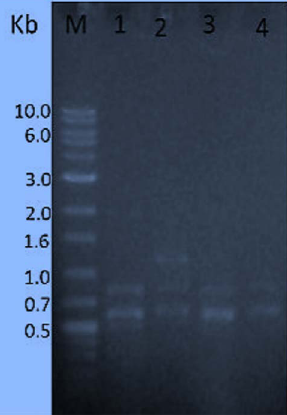
Fig. 4. DNA amplified banding profiles using primer (R3) based on RAPD for three Superior mutants (Lanes 2 to 4) and S. albogriseolus W.T (lane 1) opposite to Sizer™ -1000 plus DNA Marker (lane M). Superior mutants sequence as follows: T-40-22, T-40-29 and